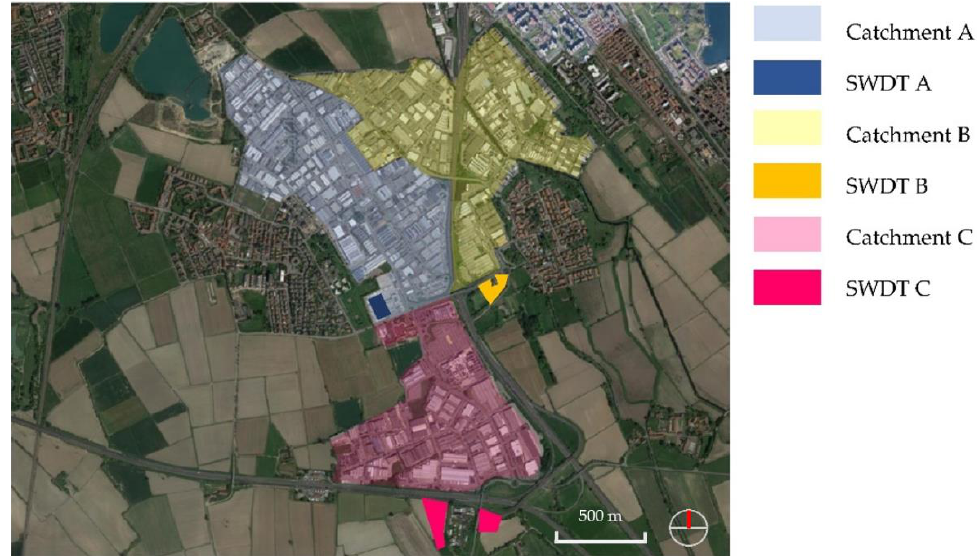
Figure 2. Localization of